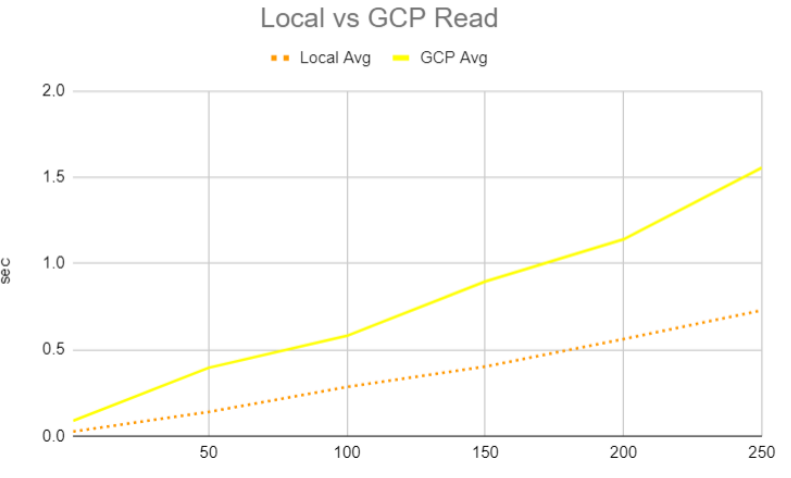
Figure 9. Average read latency comparison of a 4-node GCP and a local Docker Indy